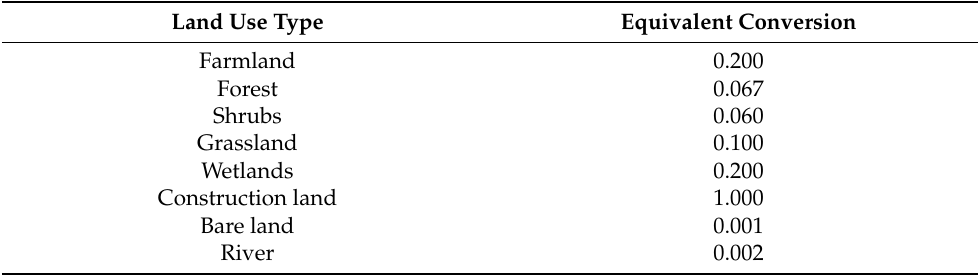
Table 2. Equivalent conversion coefficients of different land use types. Land Use